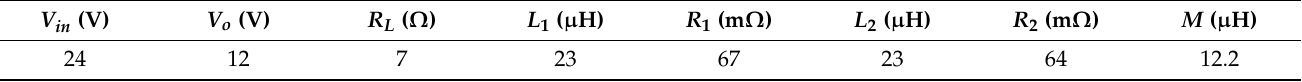
Table 1. IPTS operating parameters and component